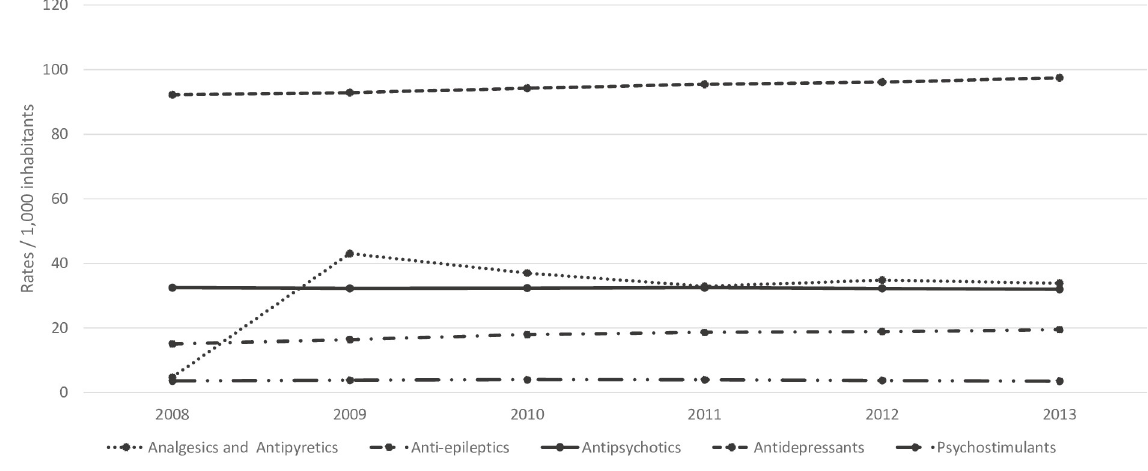
Fig 1. Trends in prescription rates for the five ATC groups.